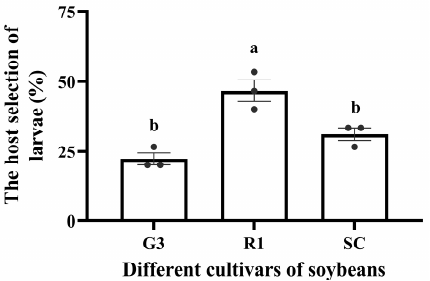
Figure 2. Host selection of C. bilineata tsingtauica larvae for different soybean cultivars. Data are means ± SEM. The lowercase letters in the figure indicate significant differences among different cultivars ( p < 0.05, Tukey test).